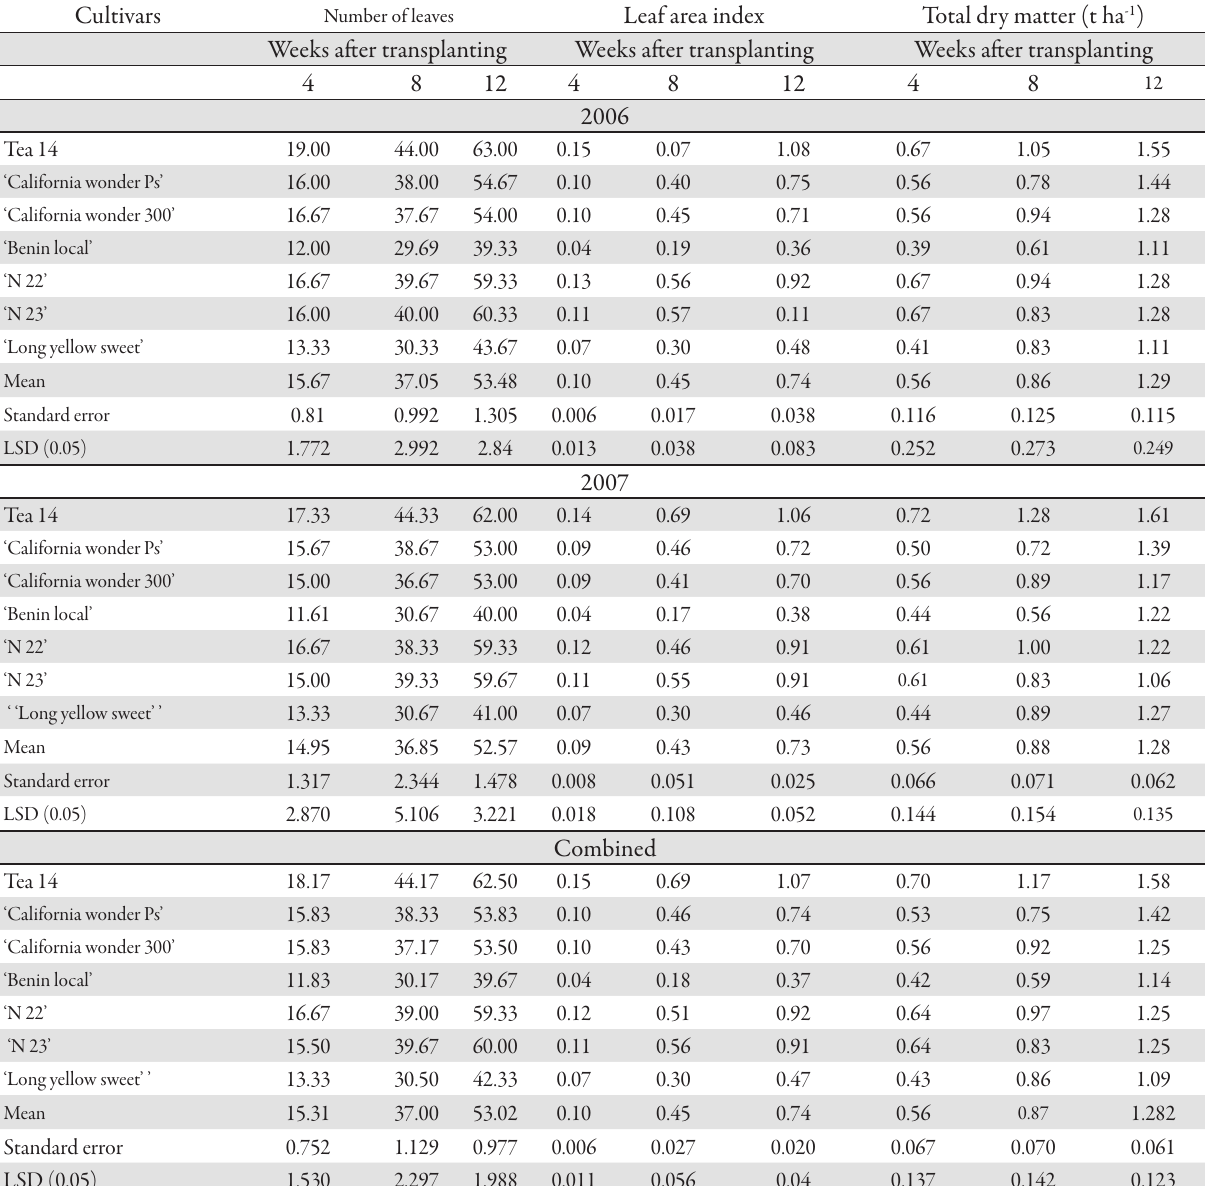
Tab. 4. Evaluation of some cultivars of C. annuum for growth Cultivars Number of